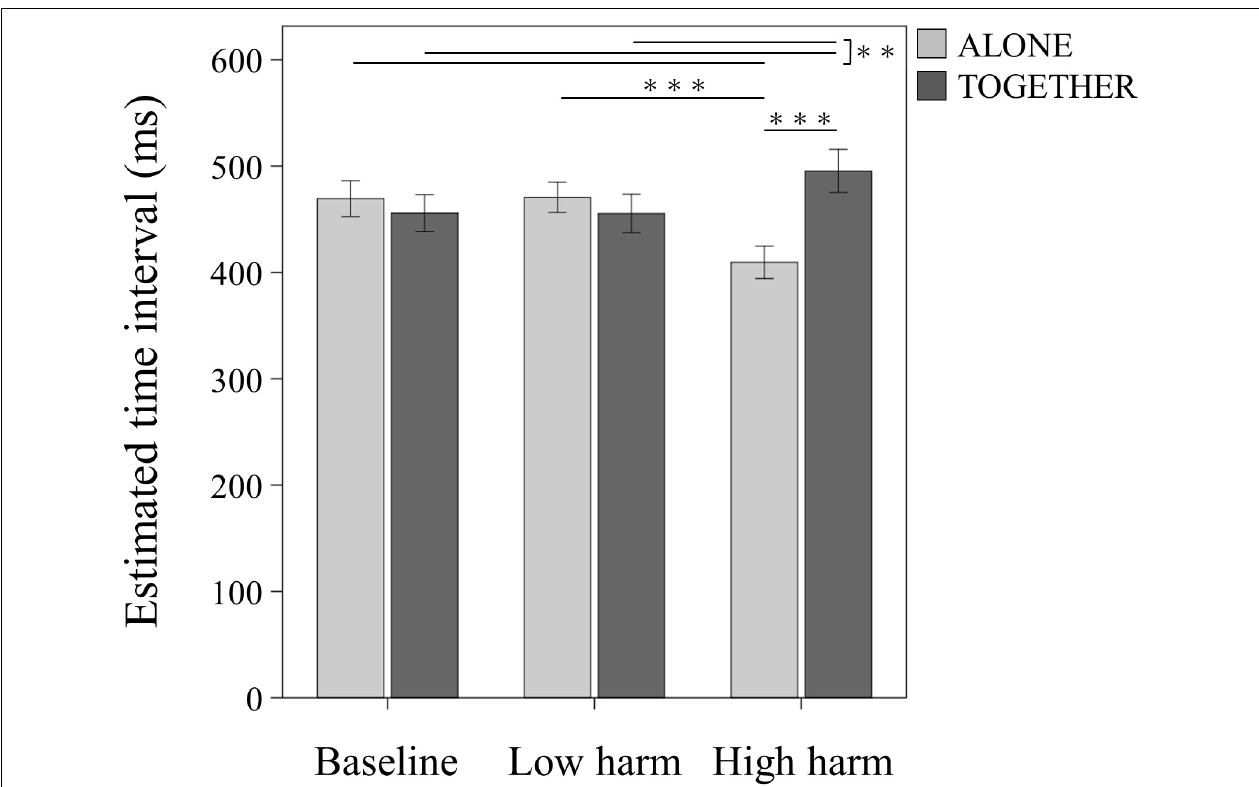
FIGURE 3 | Results of the estimated time interval. Estimated action-tone intervals (ms) in the ALONE and the TOGETHER conditions and negative outcome conditions, pooled across the three action-outcome delays. ∗∗∗ p < 0.001, ∗∗ p < 0.01. Data represent means ± standard error.